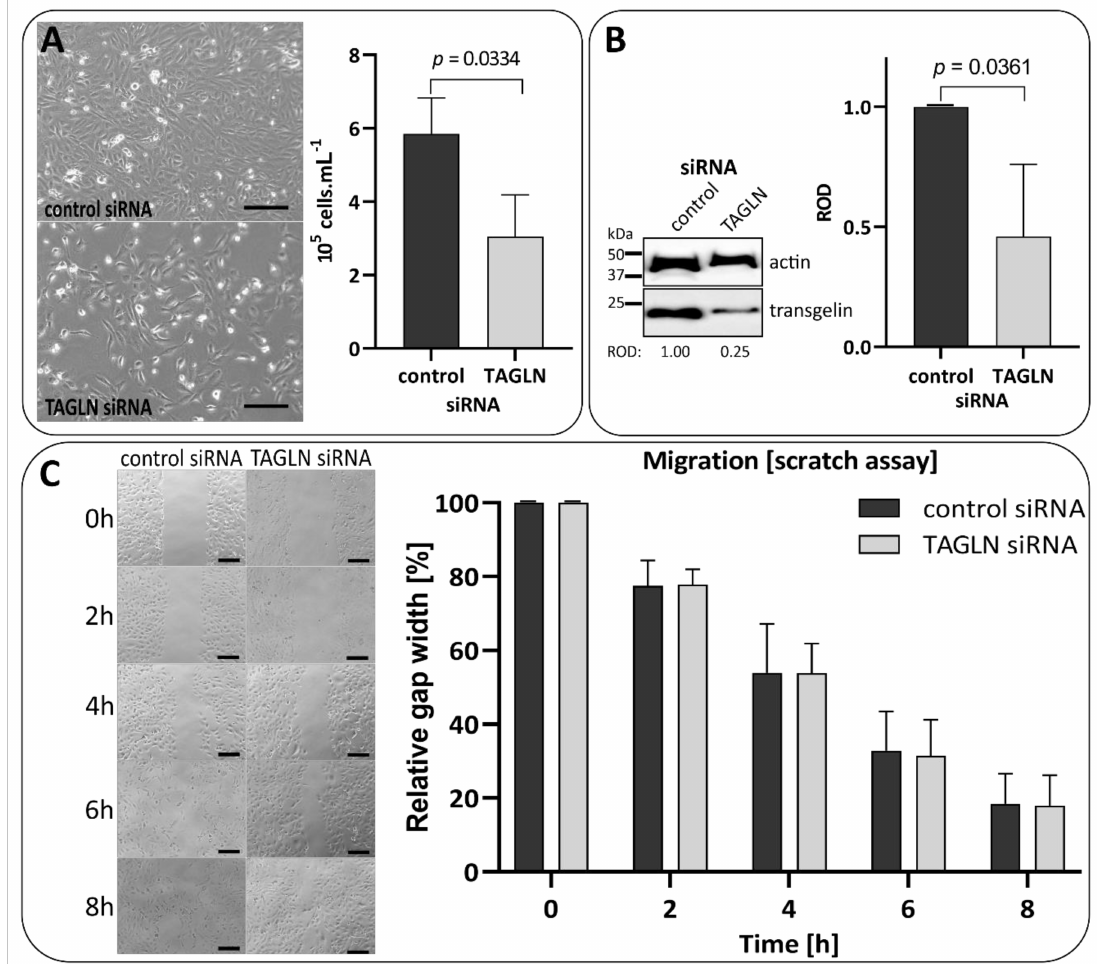
Figure 4. siRNA-based transgelin silencing slows the proliferation of 786-0 cells down. ( A ) 786-0 cells transiently transfected with control siRNA and TAGLN siRNA, 72 h post transfection. The confluence of the TAGLN siRNA-transfected cells was visually lower ( left ), and the difference in cell counts between control siRNA and TAGLN siRNA-transfected cells was significant ( right ). ( B ) Immunoblot of transgelin protein level in siRNA-transfected cells. Transgelin/actin ROD ratio was normalized to control siRNA sample. The difference in ROD ratios between control and TAGLN siRNA-transfected cells was statistically significant. ( C ) Scratch assay was scratched 96 h post transfection (three technical replicates per condition), scratches were monitored every 2 h for 8 h. The scratches were measured in five different positions, values were recalculated to percentage, normalized, and statistically evaluated. The migration rate of TAGLN siRNA-transfected cells was similar as in the control cells, and the difference was insignificant. Representative photos and immunoblots are shown; the graphs are cumulative from three independent biological experiments (for particular results, see Supplementary Figure S3). The black rows in cell photos represent 20 µ